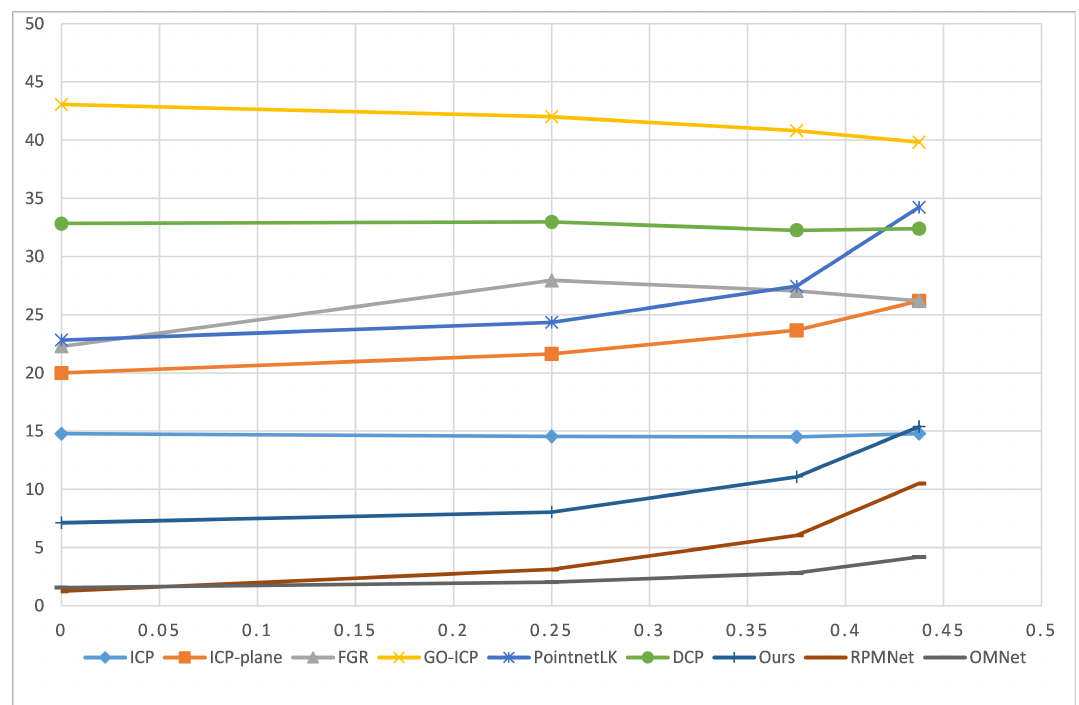
Figure 5. Influence of different sparsity levels on MAE ( R )